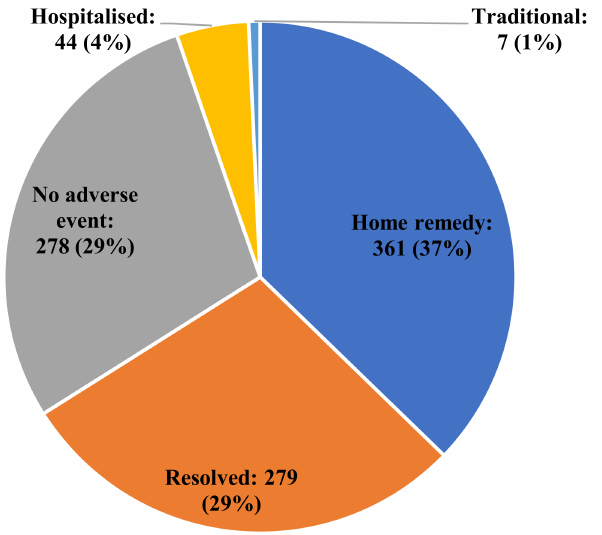
Figure 4. How adverse events of COVID-19 vaccination were treated among Africans.